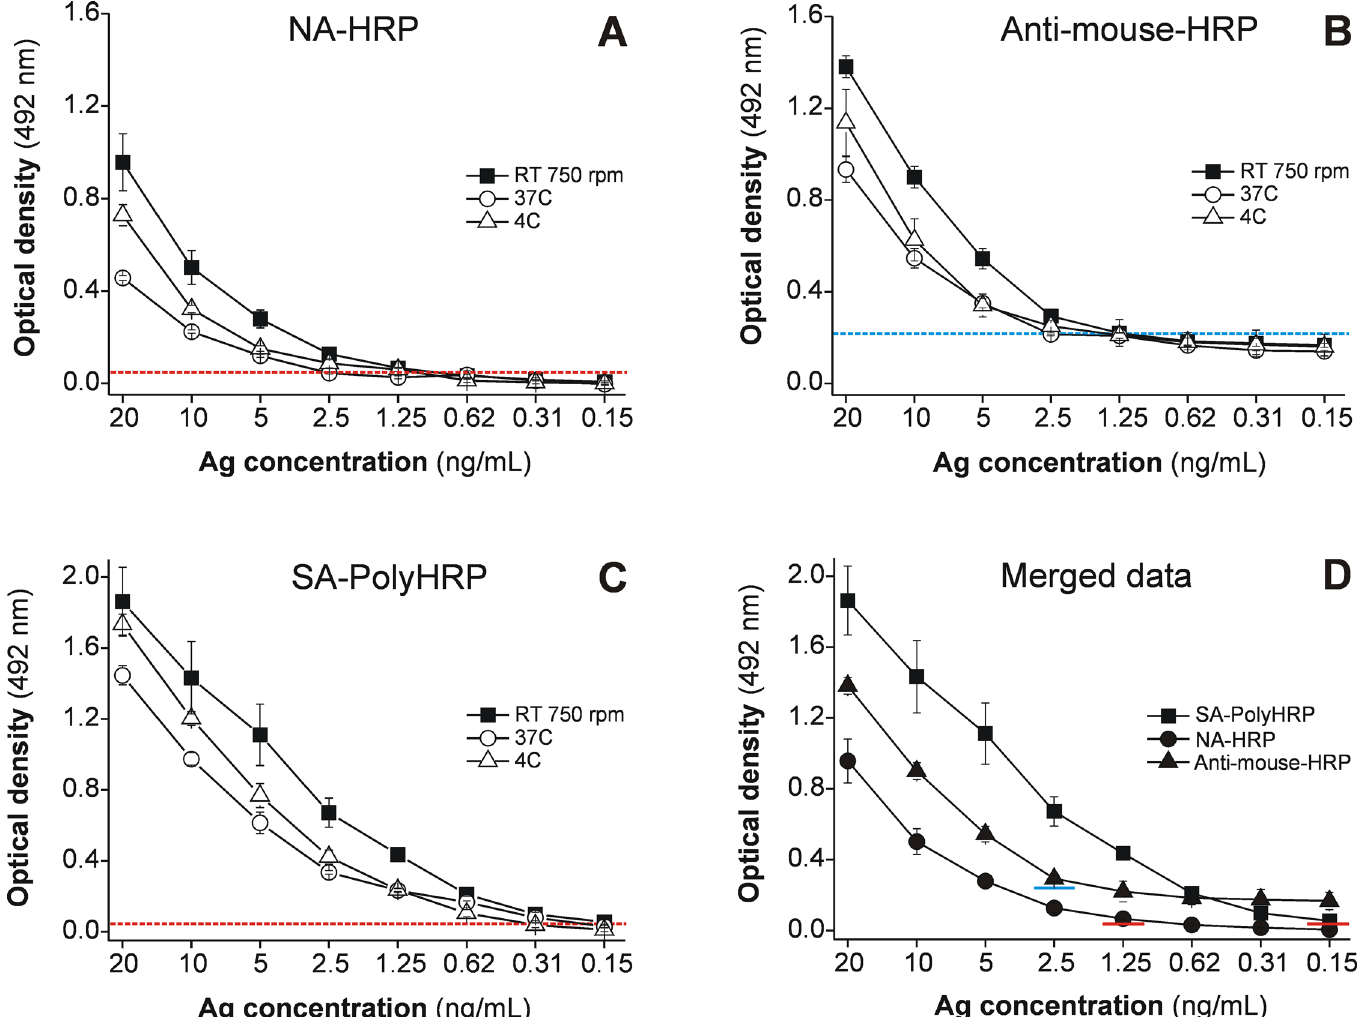
Fig 2. Comparison of three HRP-labeled secondary reagents and several incubation conditions in MM3-COPRO ELISA. The detectability of the MM3-COPRO ELISA was determined by testing two-fold dilutions (0.15 – 20 ng/mL) of Fasciola excretory-secretory antigens (Ag) diluted in CoproGuard, and bound mAb MM3 was revealed with (A) NA-HRP, (B) HRP-labeled anti-mouse IgG antibodies (anti-mouse-HRP) or (C) SA-PolyHRP. The following incubation conditions were considered: 37°C (2 h for samples; 90 min and 1 h for secondary reagents; open circles); 4°C (ON) for incubation of samples and 37°C (90 min and 1 h) for subsequent steps (open triangles); and RT (30 min) with shaking at 750 rpm for all incubation steps (closed squares). (D) Combined data obtained with the three secondary reagents and short incubations at RT (30 min, 750 rpm). The colored lines show the cut-off values calculated for anti-mouse-HRP (OD = 0.224; blue line) and SA-PolyHRP (OD = 0.055; red line) by using negative samples from